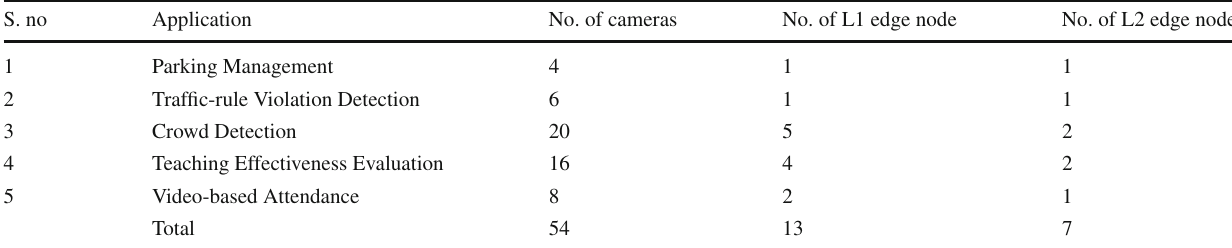
Table 4 Number of devices used for each video application